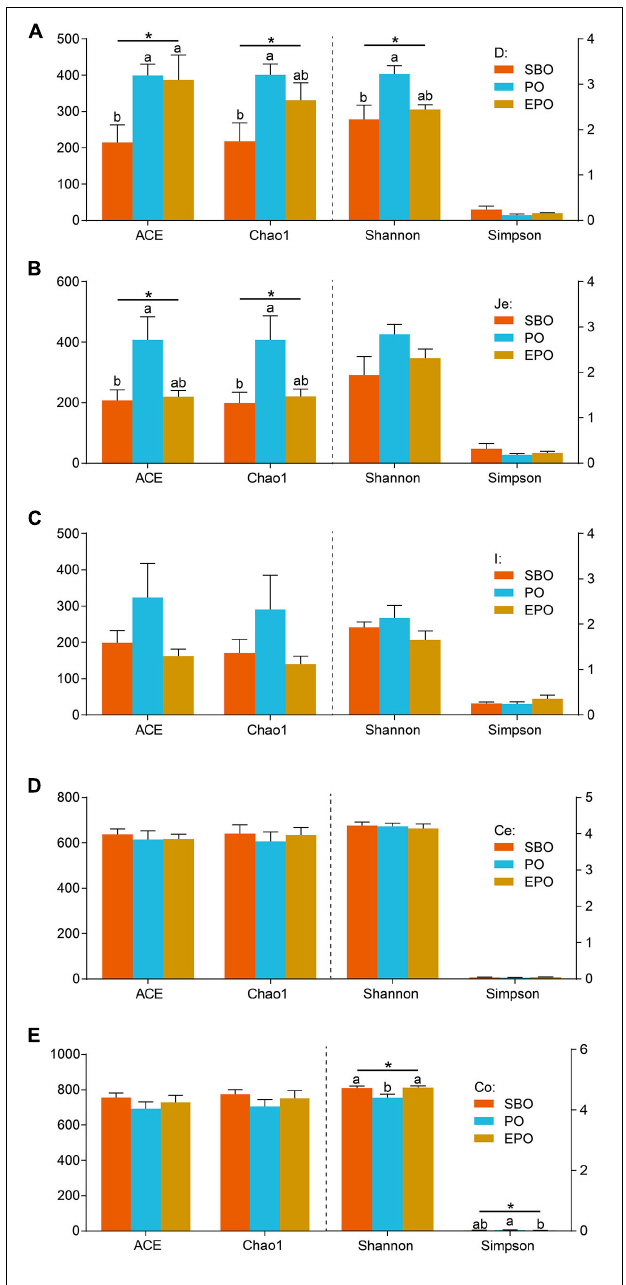
FIGURE 1 | Alpha diversity including ACE, Chao1, Shannon, and Simpson of duodenum (A) , jejunum (B) , ileum (C) , cecum (D), and colon (E) bacterial community at the 97% similarity level in the SBO, PO, and EPO groups. The values are expressed as the means ± SEM., bars with different letters are different from each other, P <